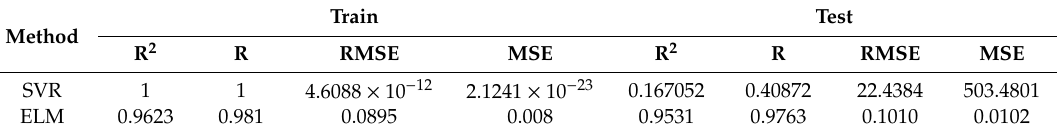
Table 6. The results of Extreme Learning Machine (ELM) using the Support Vector Regression- Radial Basis Function (SVR-RBF)